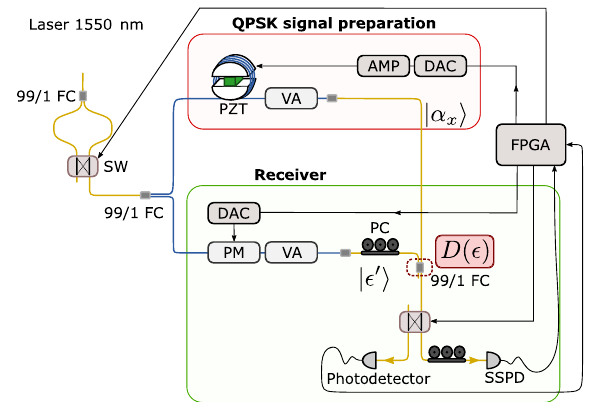
FIG. 6. Experimental setup. FC is the fiber coupler, SW is the optical switch, PM is the phase modulator, PZT is the piezo transducer, VA is the variable attenuator, PC is the polarization controller, DAC is the digital to analog converter, AMP is the amplifier, and SSPD is the superconducting a nanowire single photon detector.